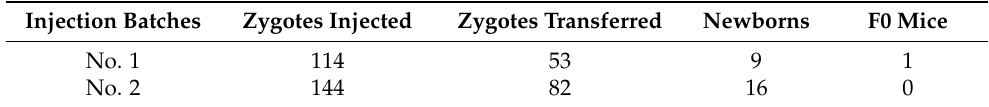
Table 1. Generation of Rag2 − / − mice by CRISPR/Cas9 technology. Injection